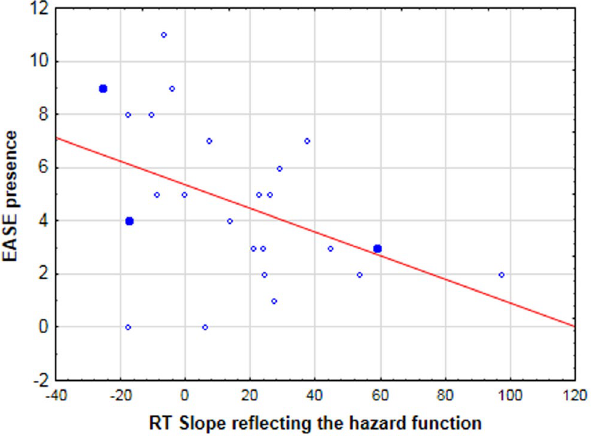
Figure 3. Scatterplot illustrating the correlation between the EASE score of ‘self-awareness and presence’ and the RT effects of the hazard function in the 0% catch trial condition. A higher ‘self-awareness and presence’ score corresponds to more severe symptoms. A lower RT slope score reflects a smaller (or even absent) benefit of the hazard